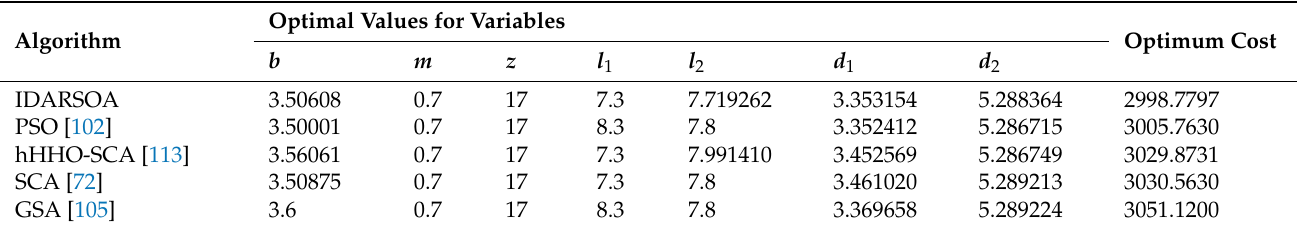
Table 14. Comparison results of speed reducer design